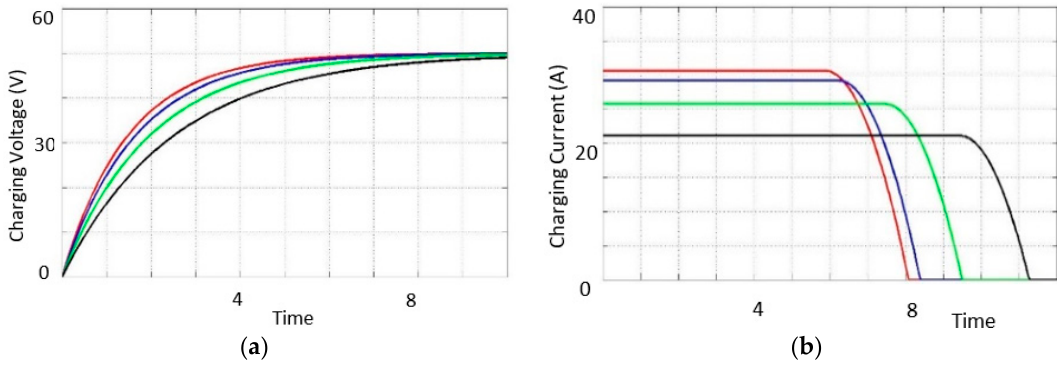
Figure 11. Supercapacitor charging waveform by SPS control DAB-IBDC converter. ( a ) Shows the time vs. voltage characteristics waveforms and ( b ) shows the time vs. current characteristics waveforms of the converter.